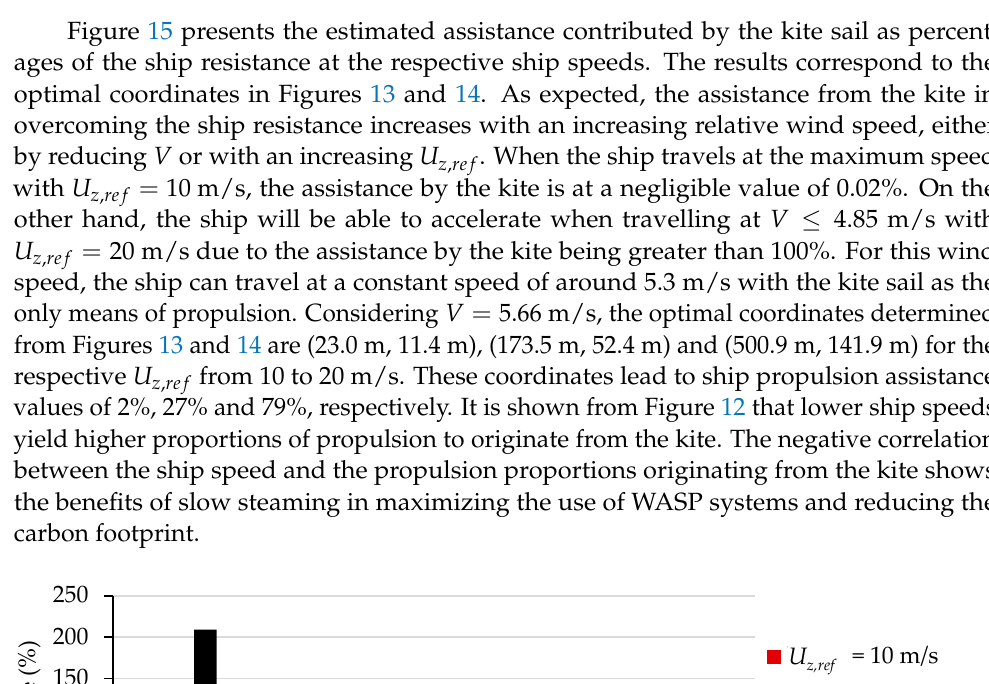
Figure 14. The optimal kite horizontal coordinates for different wind and ship speeds and a kite area of 320 m 2 .